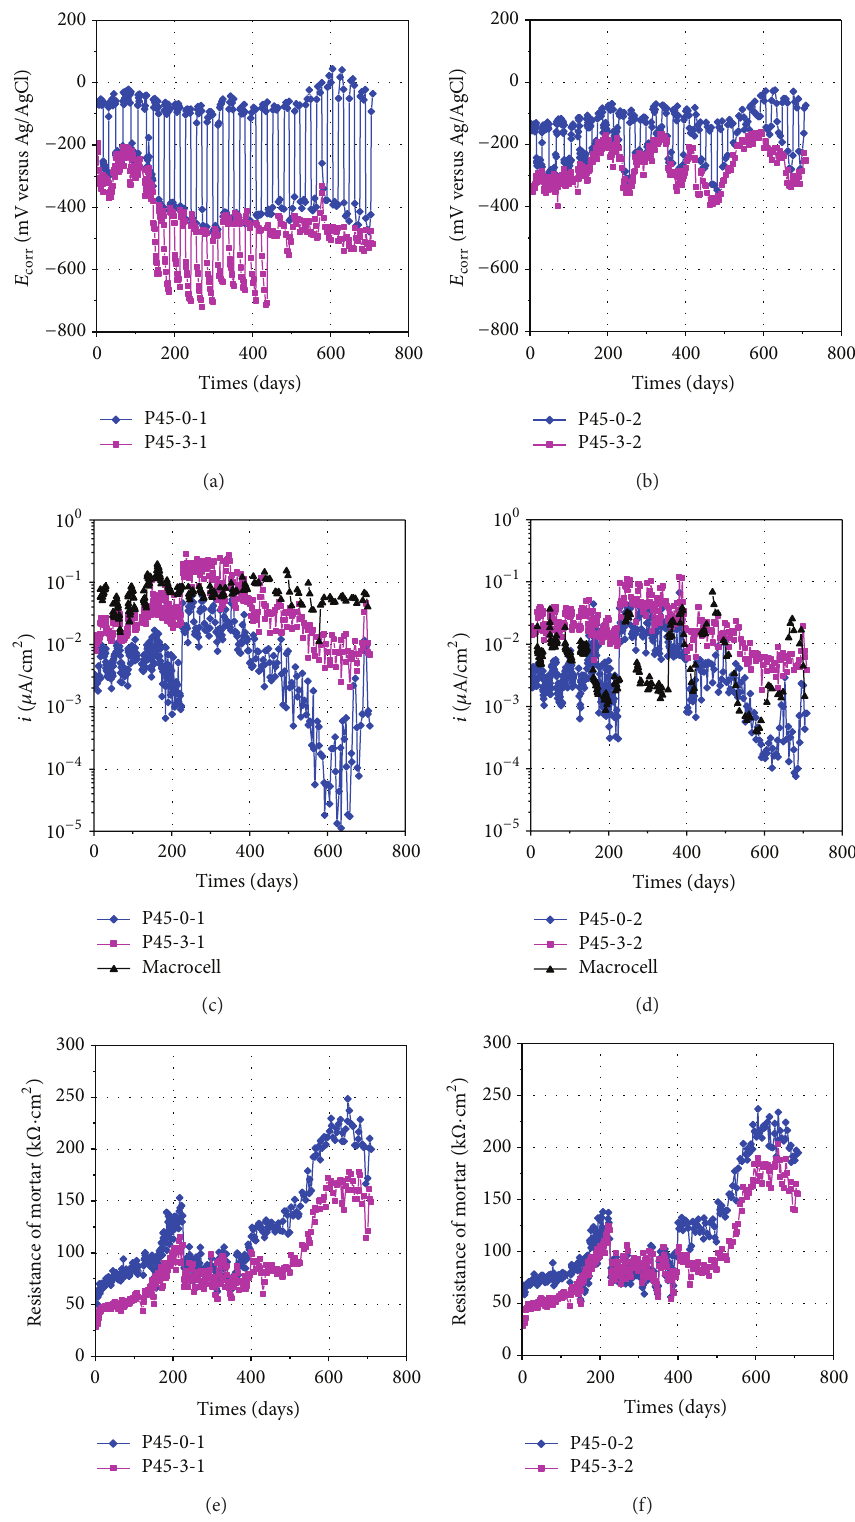
Figure 3: Time evolution curves of half-cell potential, microcell current density, macrocell current density, and resistance of mortars for cases with W/C ratio of 0.45. (a) Half-cell potential of steel in case 9-1, (b) half-cell potential of steel in case 9-2, (c) corrosion current density of steel in case 9-1, (d) corrosion current density of steel in case 9-2, (e) resistance of mortar in case 9-1, and (f) resistance of mortar in case